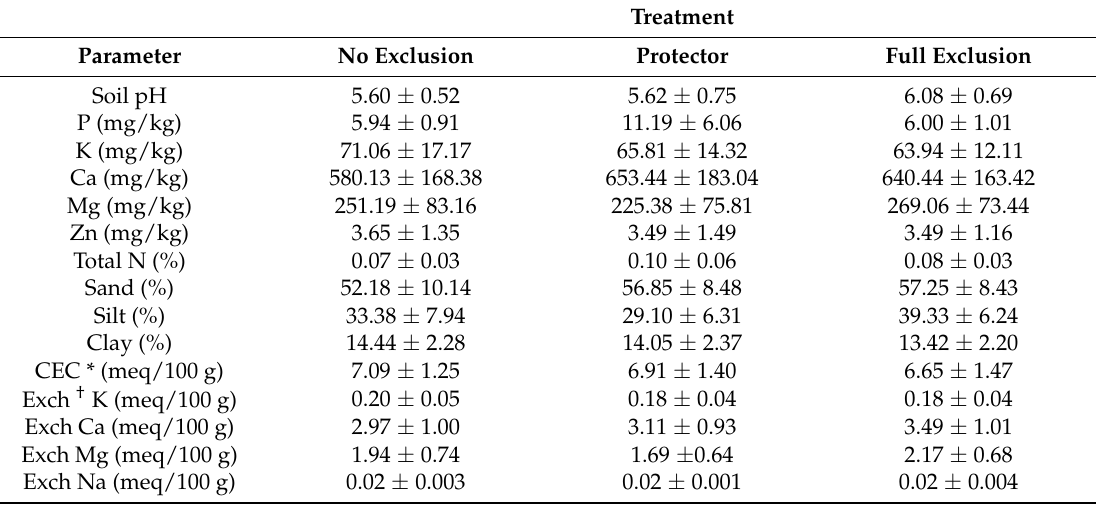
Table 1. Edaphic characteristics (Mean ± SE) across herbivore exclusion treatments on reclaimed mined lands in southeastern KY. No significant differences among exclusion treatments were detected for any of the soil parameters based upon individual Type III ANOVA models and a 0.05 significance